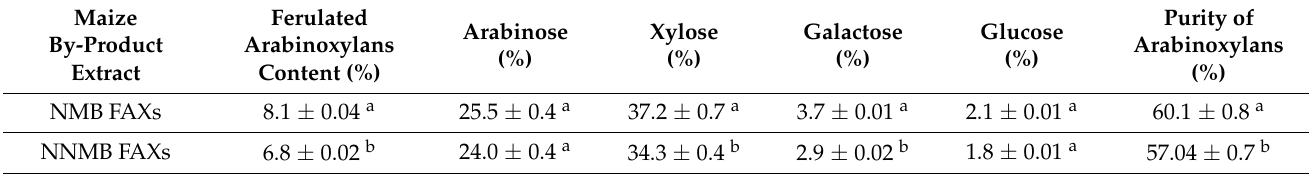
Table 1. Contents of ferulated arabinoxylans in NMB and NNMB, purity of arabinoxylans and their monosaccharide profile.